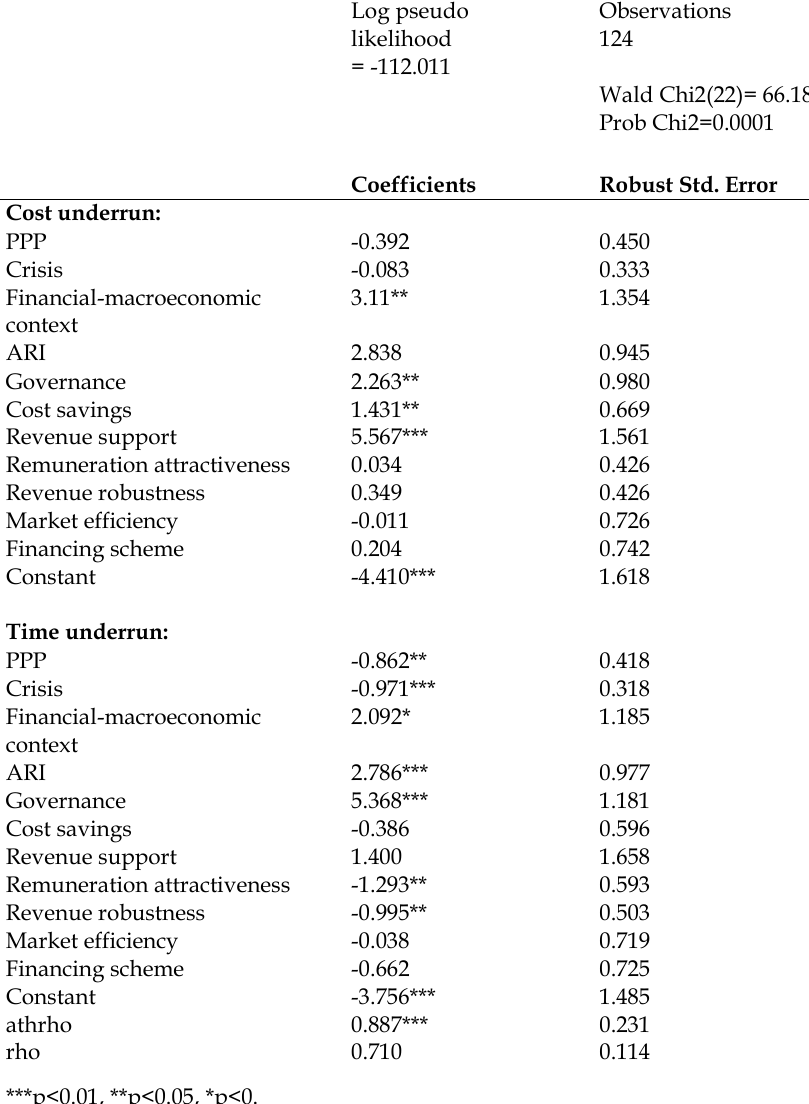
Table 1. Cost and time underrun estimation (bivariate model).